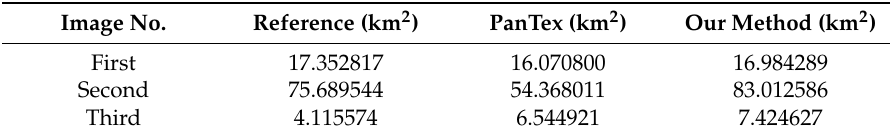
Table 3. The areas of the built-up regions by the three methods on the three test